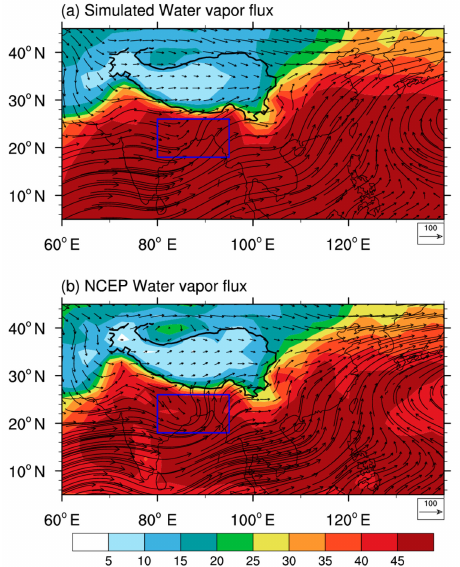
Figure 3. Evaluation of simulated atmospheric water vapor flux (kg / (m · s)) and column water vapor burden (kg / m 2 ) from surface to 100 hPa by CESM model in the summer for period from 2001–2005. ( a ) Denotes the model simulations. ( b ) Derived from the NCEP. The area of TP is enclosed by a black line. The blue rectangle indicates the region of southwest